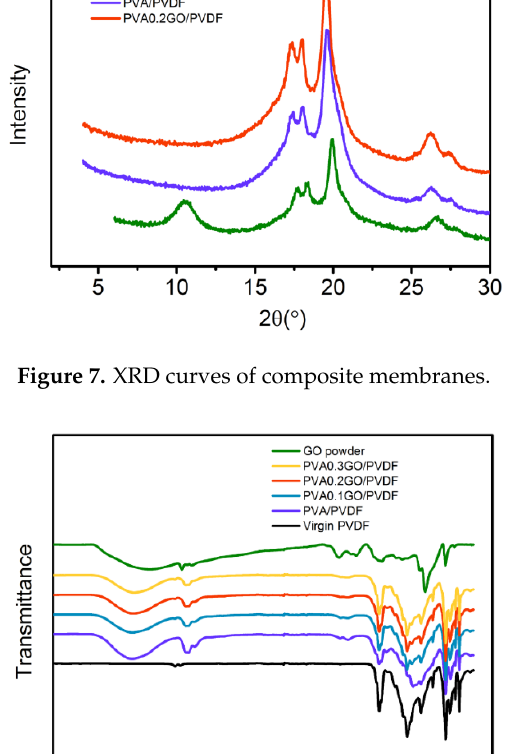
10 of 19 Figure 6. Surface SEM images of composite membranes fabricated with cast coating method: ( a ) pure PVA coating; and PVA ‐ GO hybrid coating with ( b ) 0.1 wt. %, ( c ) 0.2 wt. %, ( d ) 0.3 wt. % GO loading.